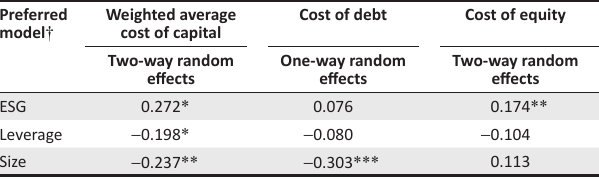
TABLE 6: Regression results for the composite environmental, social and corporate governance disclosure scores for the industrials sector. Preferred model †